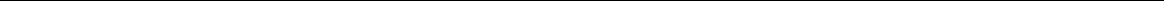
Fig. 4 Checkpoint kinases ensure cell survival upon replicative stress. a HCT116 cells were pretreated with 3 µ M KU-60019 for 1 h followed by stimulation with 1mM hydroxyurea (HU) for 24 – 48h. Cell death was detected using PI staining and fl ow cytometry. Results are displayed as mean ± SD ( n 24 h = 3, n 48 h = 4; one-way ANOVA, *** P < 0.001; **** P < 0.0001). b Western blot analysis of HCT116 cells treated with KU-60019 and HU for 24 h as described in a . ɣ